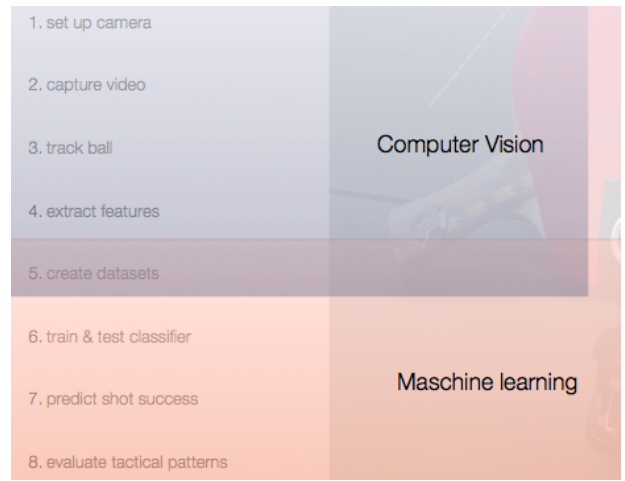
Figure 1. Overview over our